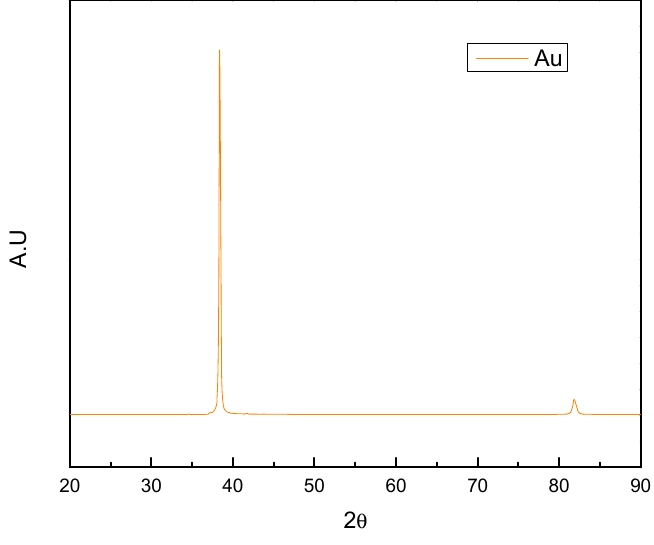
Figure 3. Gold coating pattern studied using XRD.